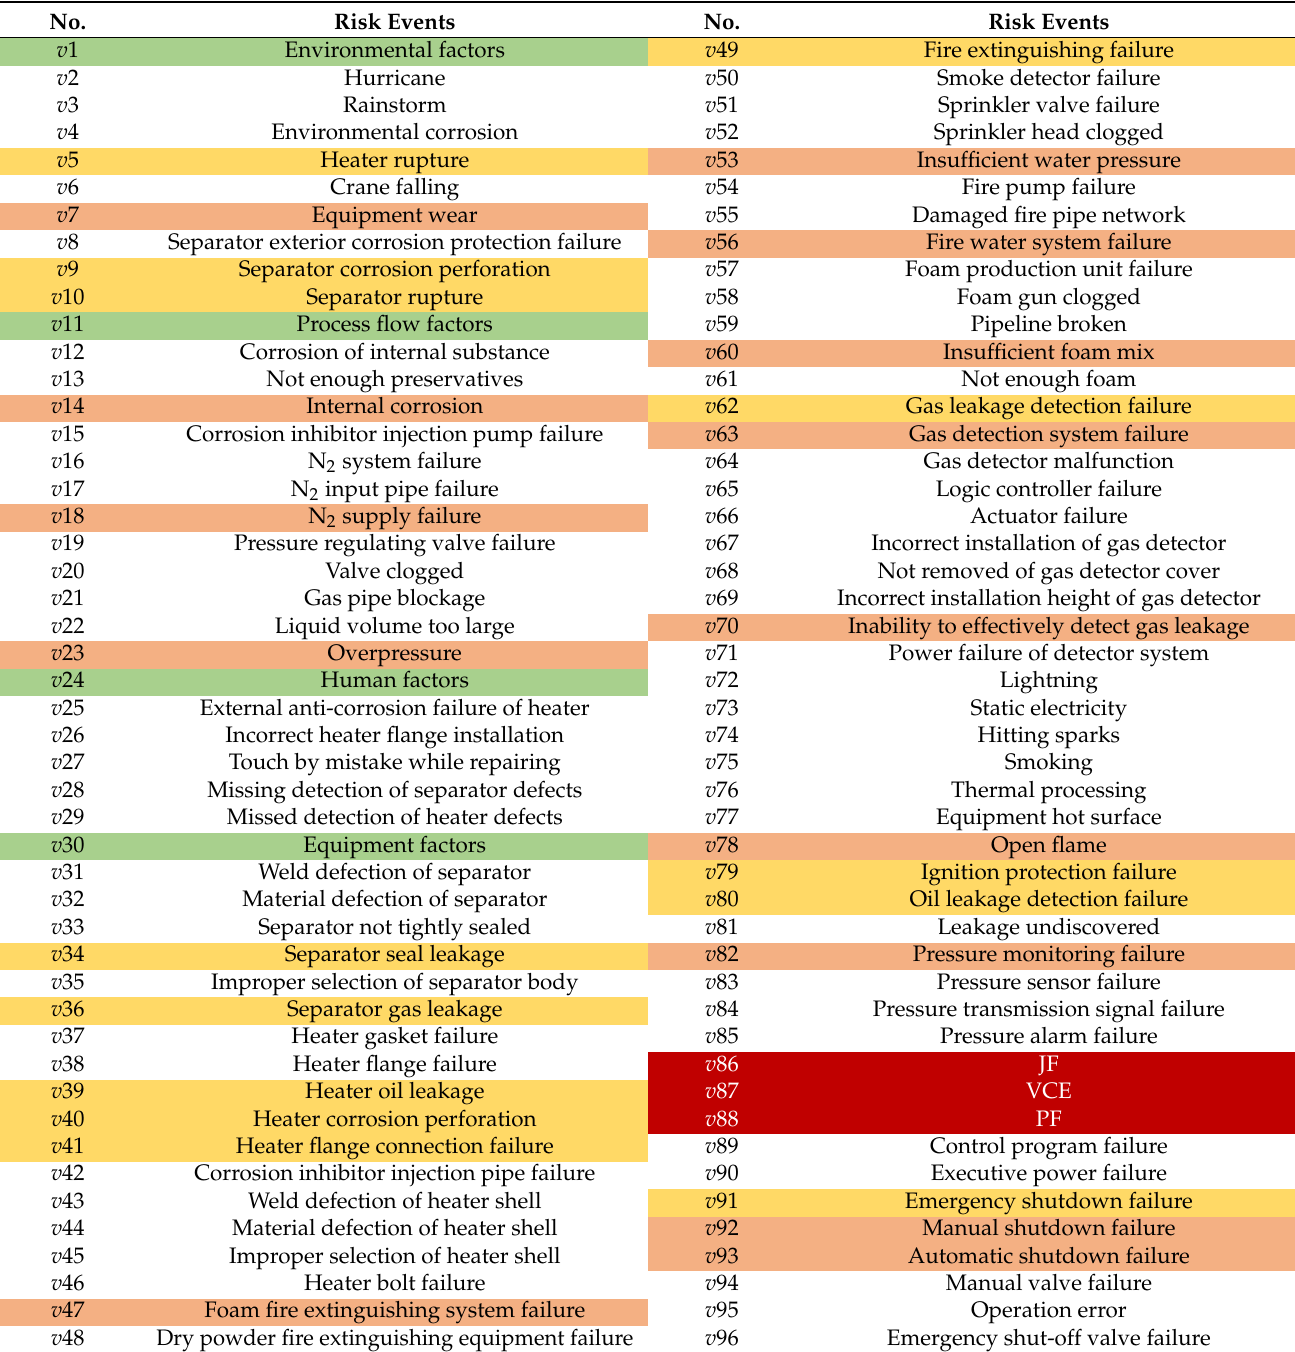
Table 6. Risk events for fire and explosion accident in oil and gas processing